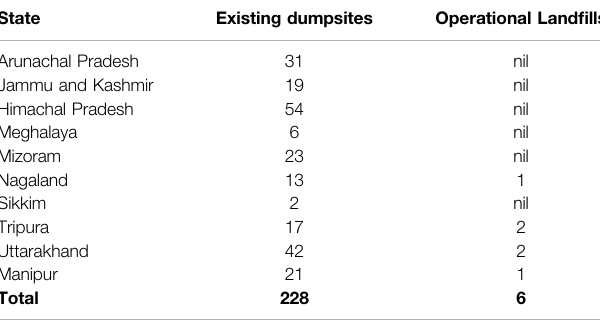
TABLE 3 | The existing dumpsites and operational land fi lls in the IHR (Data source: CPCB, 2019). State